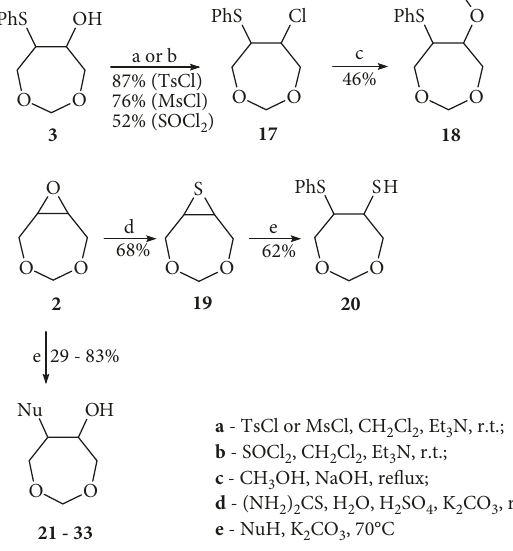
Scheme 3: Synthesis of new functional derivatives of 1,3-dioxepane